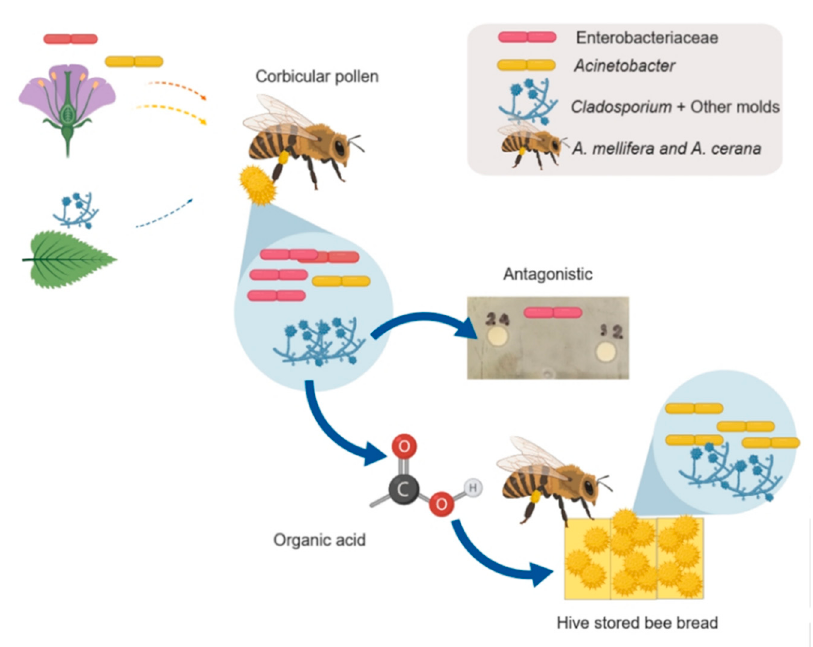
Figure 5. Possible routes and roles of dominant microbes associated with hive-stored bee bread in 2 honey bees.